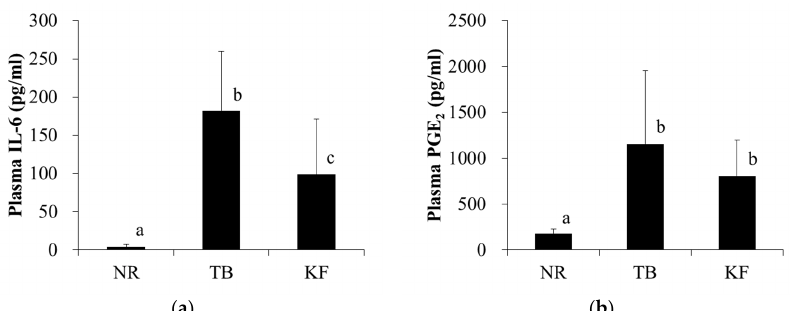
Figure 3. Effect of ketogenic diet on gastrocnemius muscle and epididymal fat mass in a mouse model of colorectal cancer. Legend: Tissue weights were recorded on the day of necropsy (day 21 after tumor inoculation). ( a ) gastrocnemius muscle; ( b ) epididymal fat. Values are means ± standard deviations, and values with different superscripts are significantly different ( p < 0.05). NR, normal group; TB, tumor-bearing group; KF, ketogenic formula group.